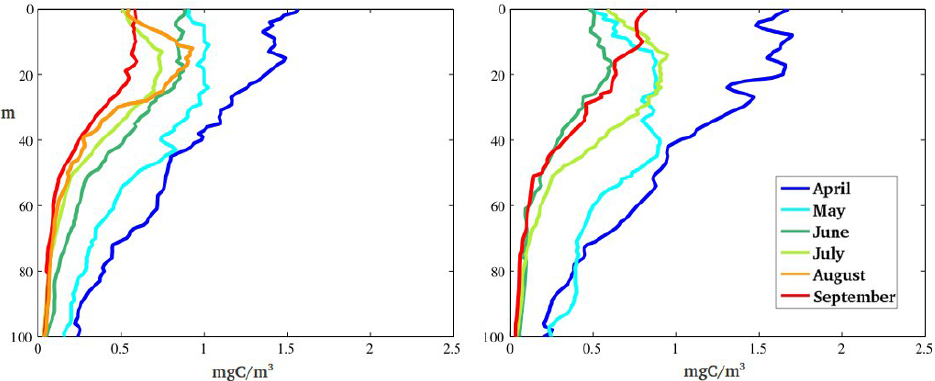
Fig. 6. Monthly CHL profiles averaged over all the C pd categories. Left: for the Greenland Sea (north of 66 ◦ 33 0 39 00 N, 45 ◦ W–20 ◦ E). Right: for the smaller highly sampled region at Fram Strait only (77–82 ◦ N, 5 ◦ W–10 ◦ E). At Fram Strait in August only too few profiles (less than 20) were available and therefore are not compared with other months. Data are from R/V Polarstern and Maria S. Merian cruises (unpublished), and from ARCSS-PP database,